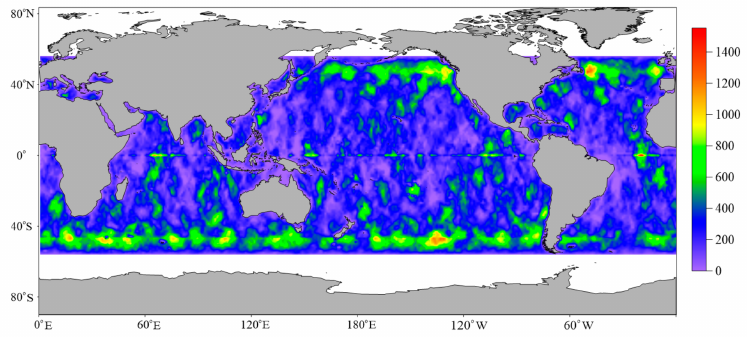
Figure 3. The number distribution of RapidScat and The Advanced Scatterometer (ASCAT) collocated data